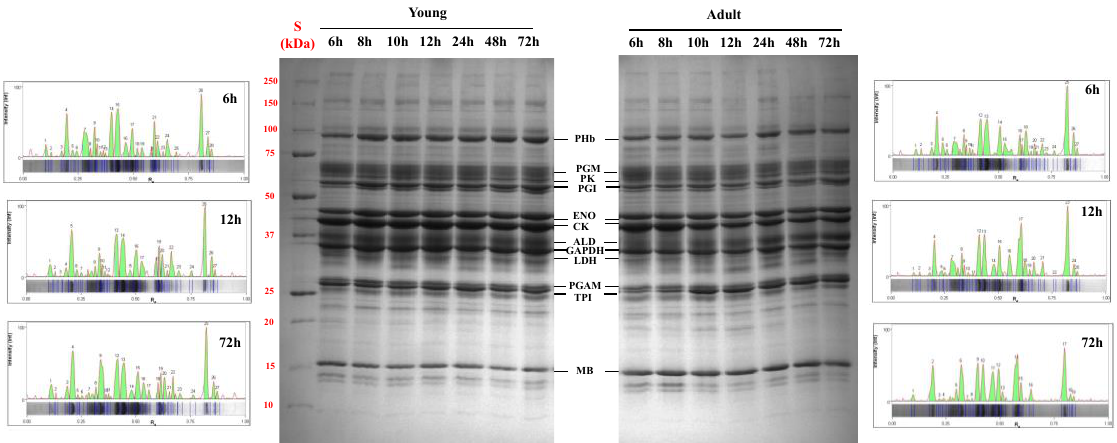
Figure 1. Representative SDS-PAGE (8 – 18%) and densitometric profiles of sarcoplasmic proteins from the longissimus lumborum muscles of young and adult dromedaries after 6, 8, 10, 12, 24, 48 and 72 h postmortem (St = standard; PHb = phosphorylase b; PGM = phosphoglucomutase; PK = pyruvate kinase; PGI = phosphoglucose isomerase; ENO = enolase; CK = creatine kinase; ALD = aldolase; GAPDH = glyceraldehyde phosphate dehydrogenase; LDH = lactate dehydrogenase; PGAM = phosphoglycerate mutase; TPI = triosephosphate isomerase; and MB = myoglobin). Image analysis results of the main sarcoplasmic proteins extracted from the longissimus lumborum muscles, as affected by slaughter age and postmortem time, are presented in Figure 2. Age at slaughter affected the electrophoretic profile of sarcoplasmic proteins, with adult dromedaries being characterized by higher values of myoglobin ( p < 0.001) during all postmortem times. Myoglobin levels may reflect differences in the contractile and metabolic properties of muscle fibers. In our study the higher abundance of myoglobin found in the meat of adult dromedaries highlights the reddest meat, and confirms that the increase in myoglobin content is a process closely connected with an animal’s age, as previously reported [5,26]. In addition, meat from adult dromedaries showed higher values of phosphoglucomutase (PGM; p < 0.01) at 6 and 8 h postmortem, while meat from young (CK; p < 0.01) after 8 and 24 h of postmortem storage,